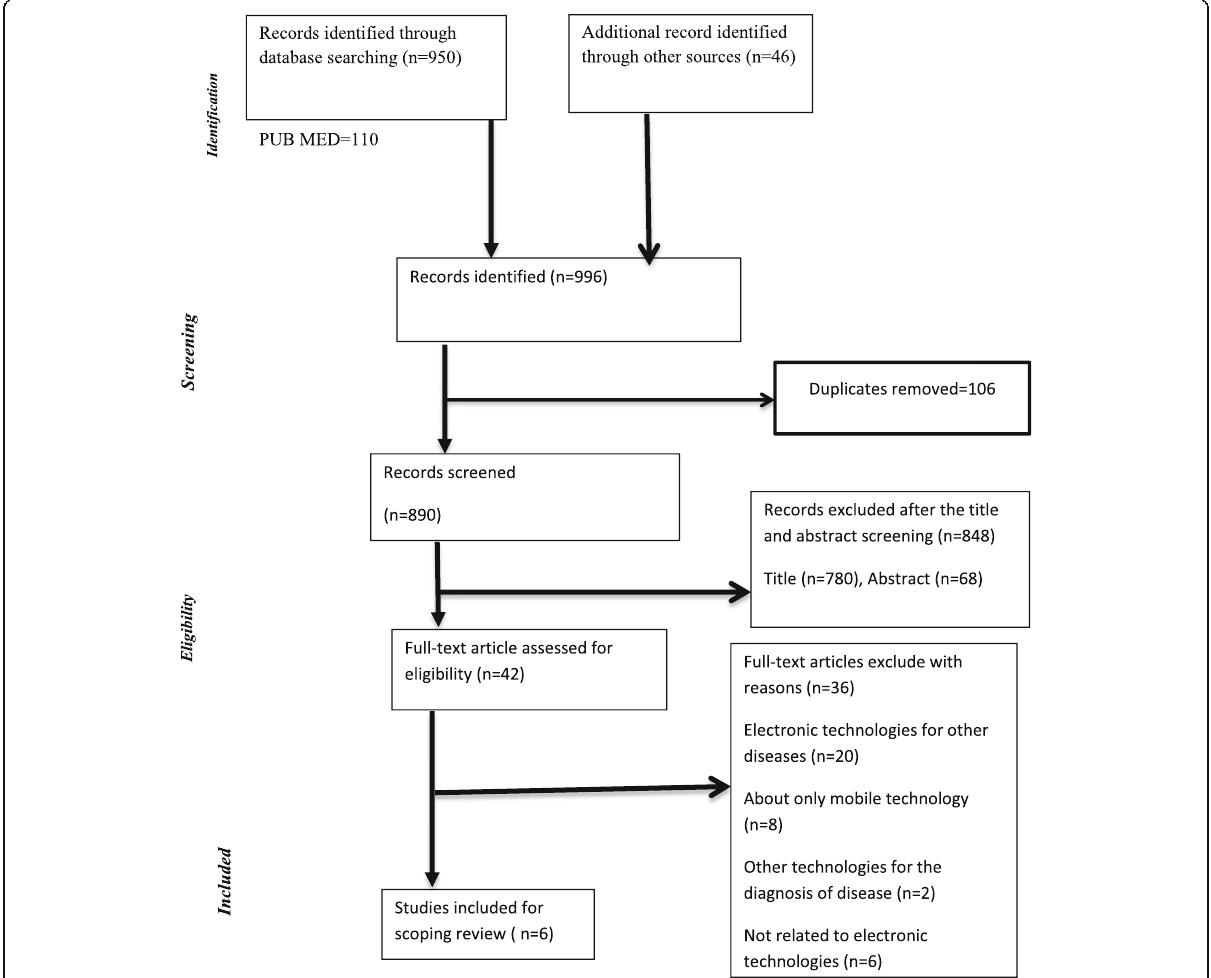
Fig. 1 Flow diagram for the scoping review process adapted from the PRISMA statement by Moher and colleagues (2009)